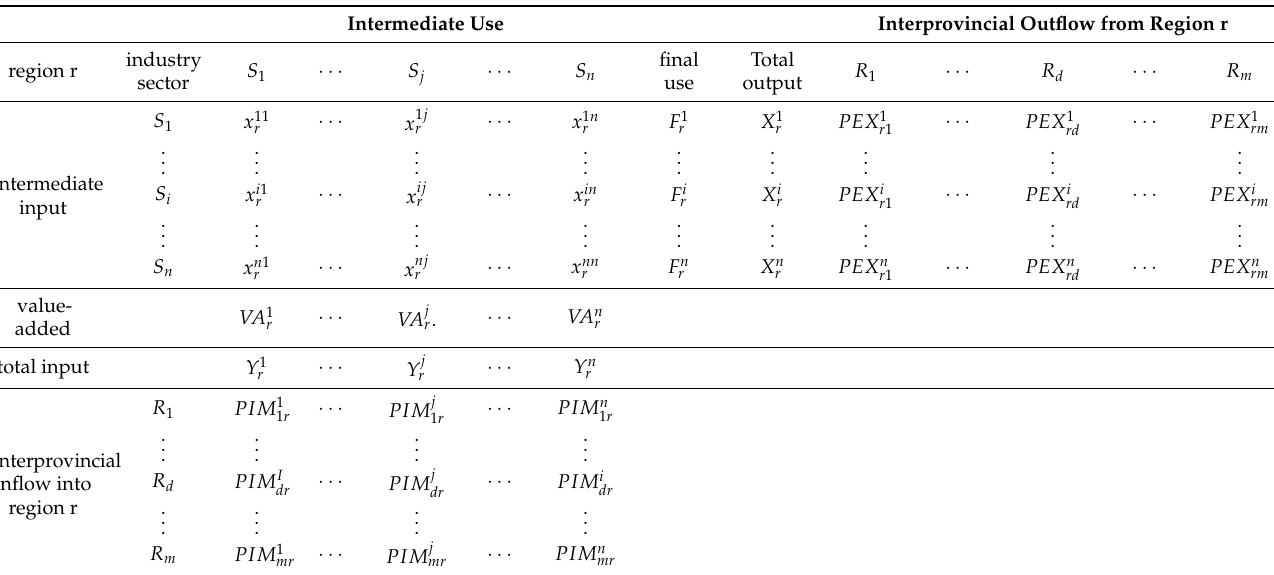
Table 1. The basic structure of the MRIO